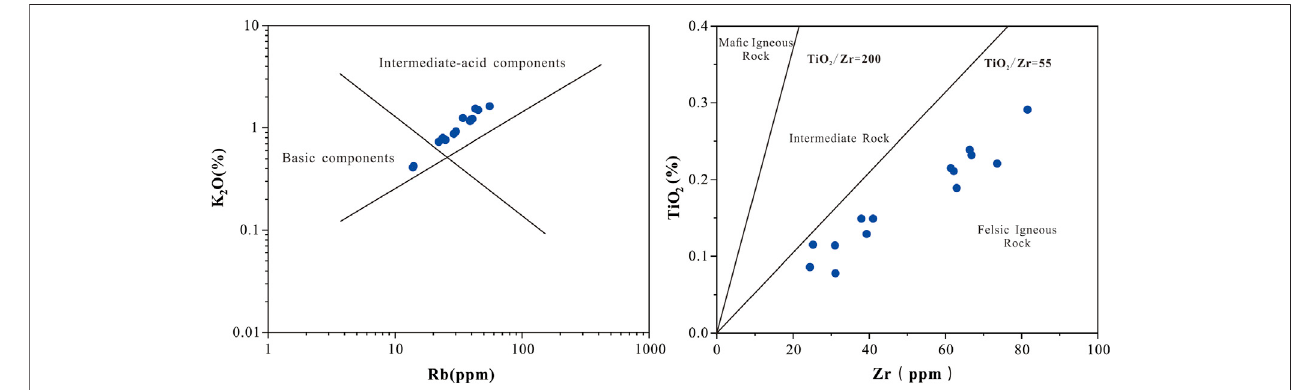
FIGURE 11 | K 2 O – Rb and TiO 2 – Zr diagram of Longfeng quarry section.